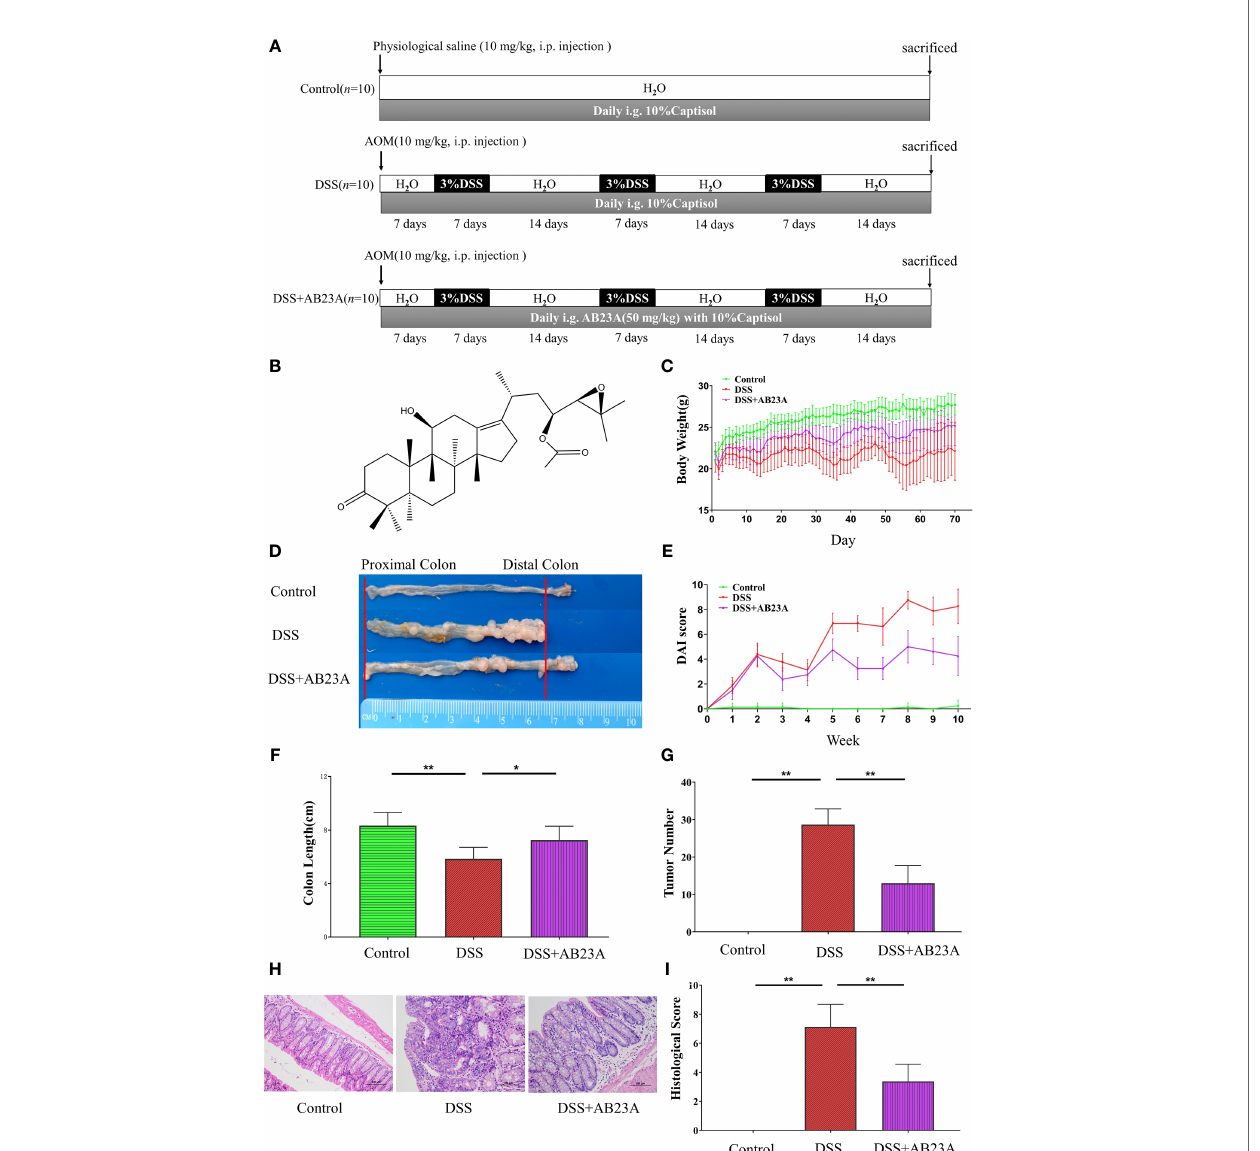
FIGURE 1 | AB23A treatment ameliorated pathological damage in AOM/DSS-induced CAC mice. (A) The overview of the animal experiment design. (B) Chemical structure of AB23A. (C) Body weight changes in each group (n = 10). (D) Colon tumor burden in each group. (E) DAI scores (n = 10). (F) Colon lengths in each group (n = 6). (G) Colon tumor numbers in each group (n = 6). (H) Micrographs of HE-stained colon tissues in each group (n = 3). (I) Histological scores of each group (n = 3). Data are expressed as mean ± SD. Differences in (B, D – F, H) were analyzed by one-way ANOVA followed by Tukey ’ s post hoc test (*P < 0.05, **P <